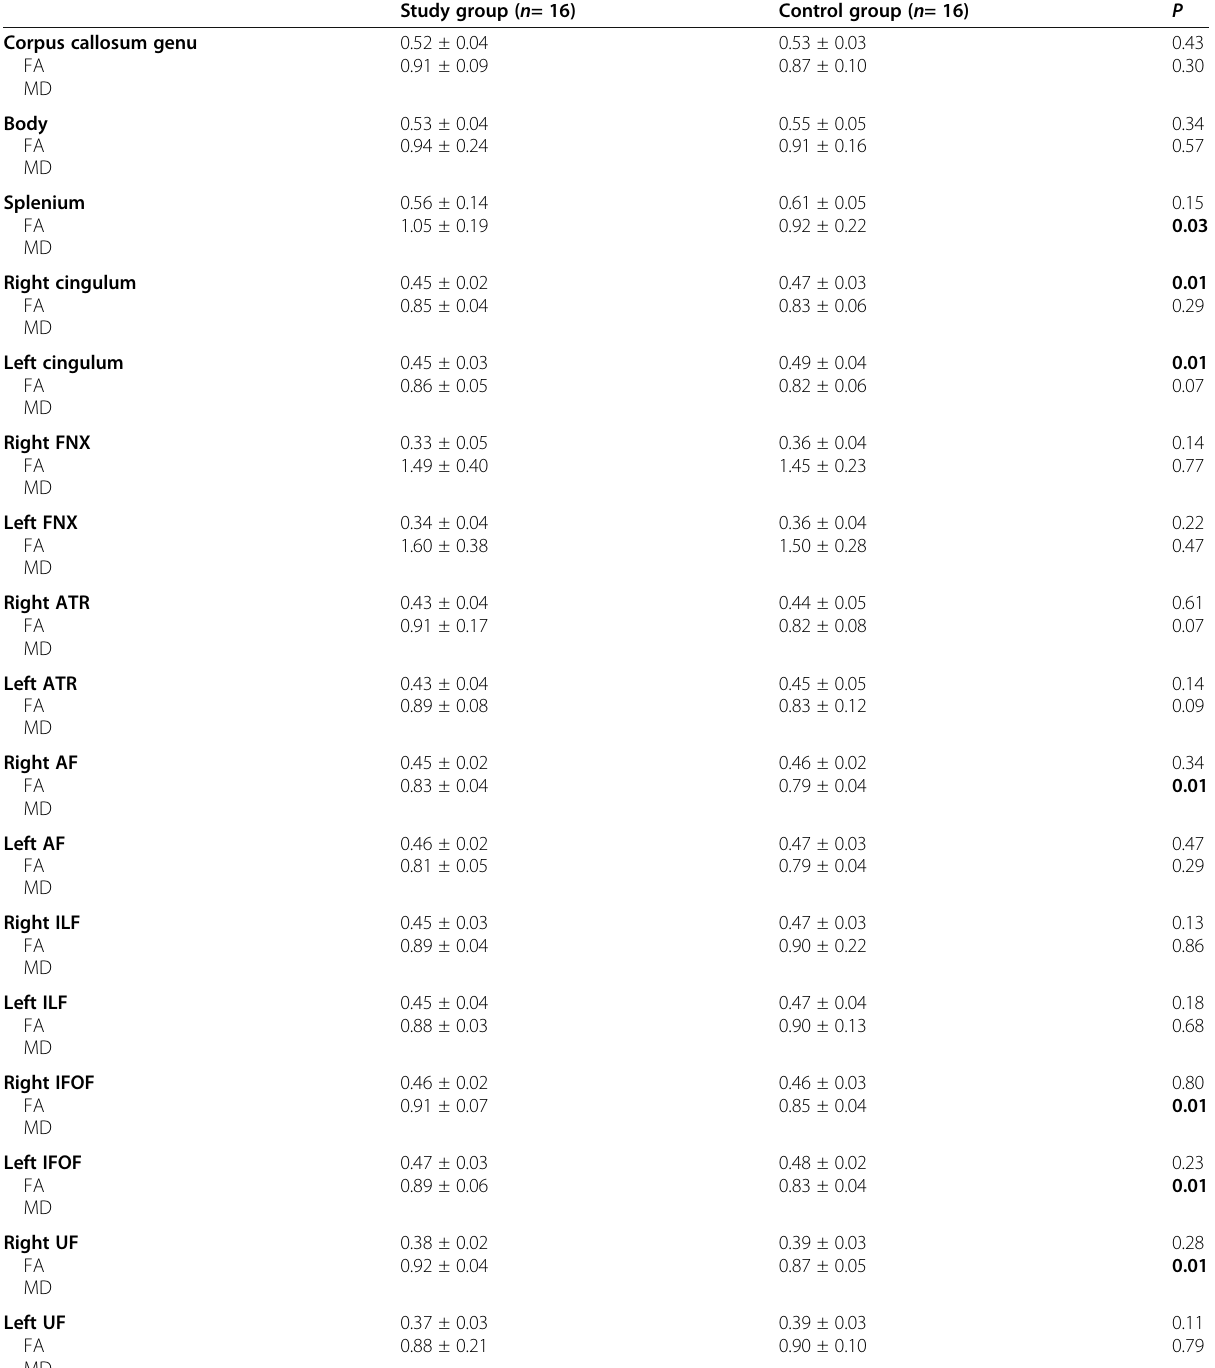
Table 2 DTI parameters of the corpus callosum, cingulum, fornix, anterior thalamic radiation, AF, ILF, IFOF, and UF in the studied